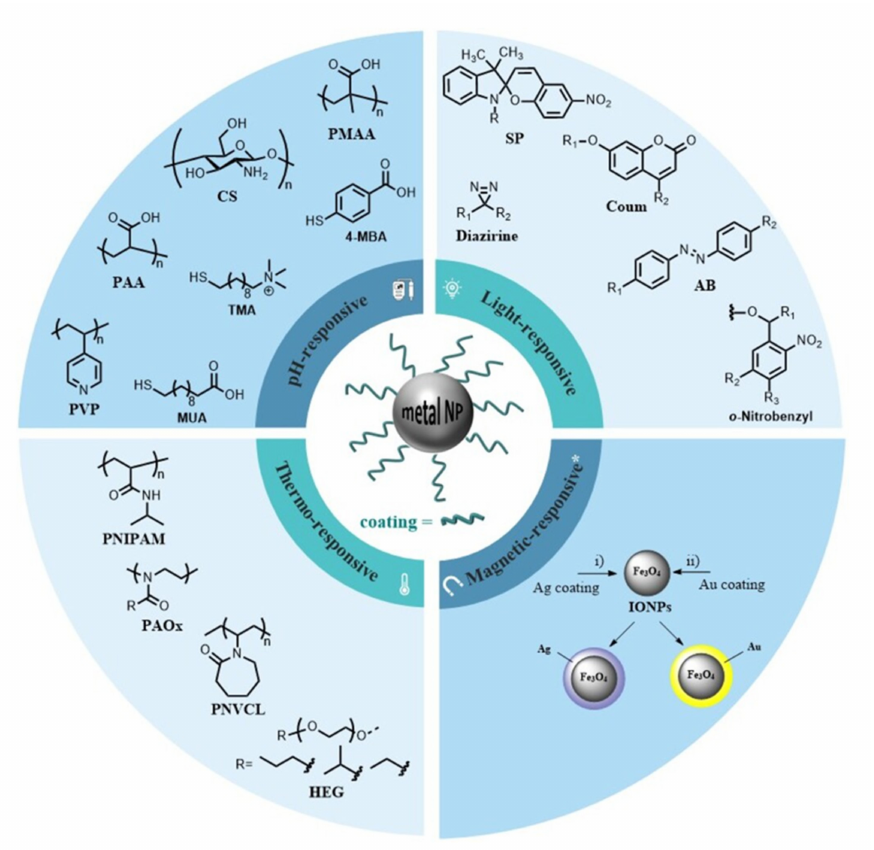
Figure 3. Molecules and macromolecules frequently used to coat MNPs resulting in stimuli-sensitive nanosystems. * Magnetic core NPs (i.e., Fe3O4 NPs) are decorated with silver or gold to obtain magnetic-responsive